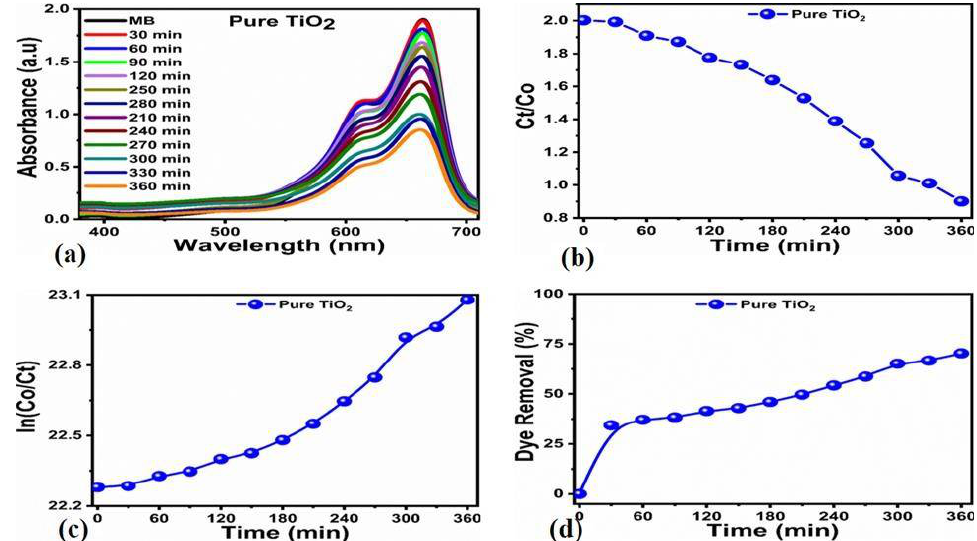
Figure 5. Changing in UV–vis spectra of pure TiO 2 ( a ), plot of Ct. Co verses irradiation of photodegradation of MB at various times ( b ), pseudo-first order plot for photodegradation of MB ( c ) and shows the calibration curve of dye removal (%) under natural light illumination of only hydrothermally treated bulk TiO 2 material ( d ).